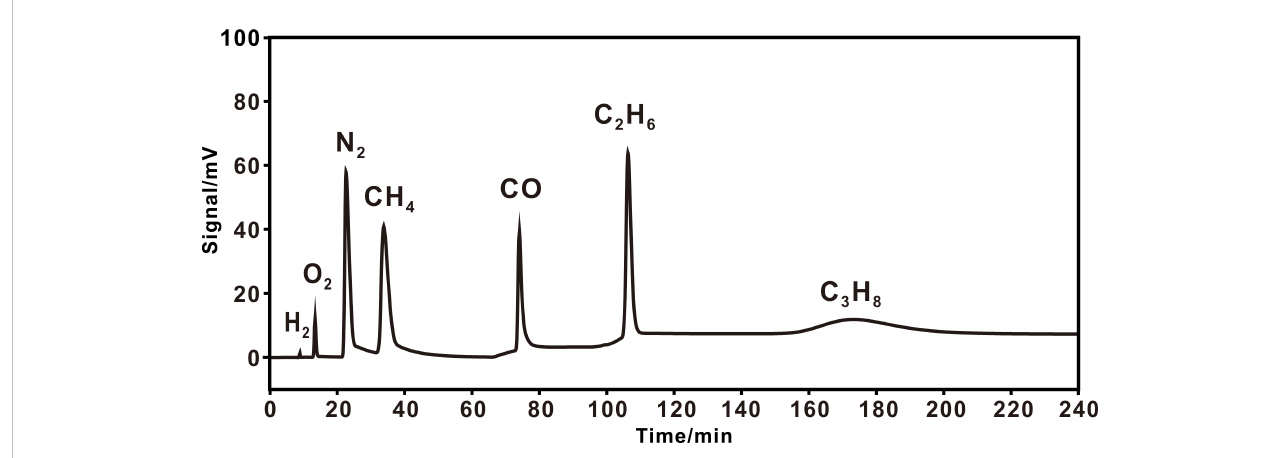
FIGURE 3 Typical chromatogram of a natural gas under 3,1.5,1/4 columns. A heating procedure was adopted with an initial temperature of 25 °C (65 min), heating at 10 °C min – 1 to 120 °C (20 min), then to 200